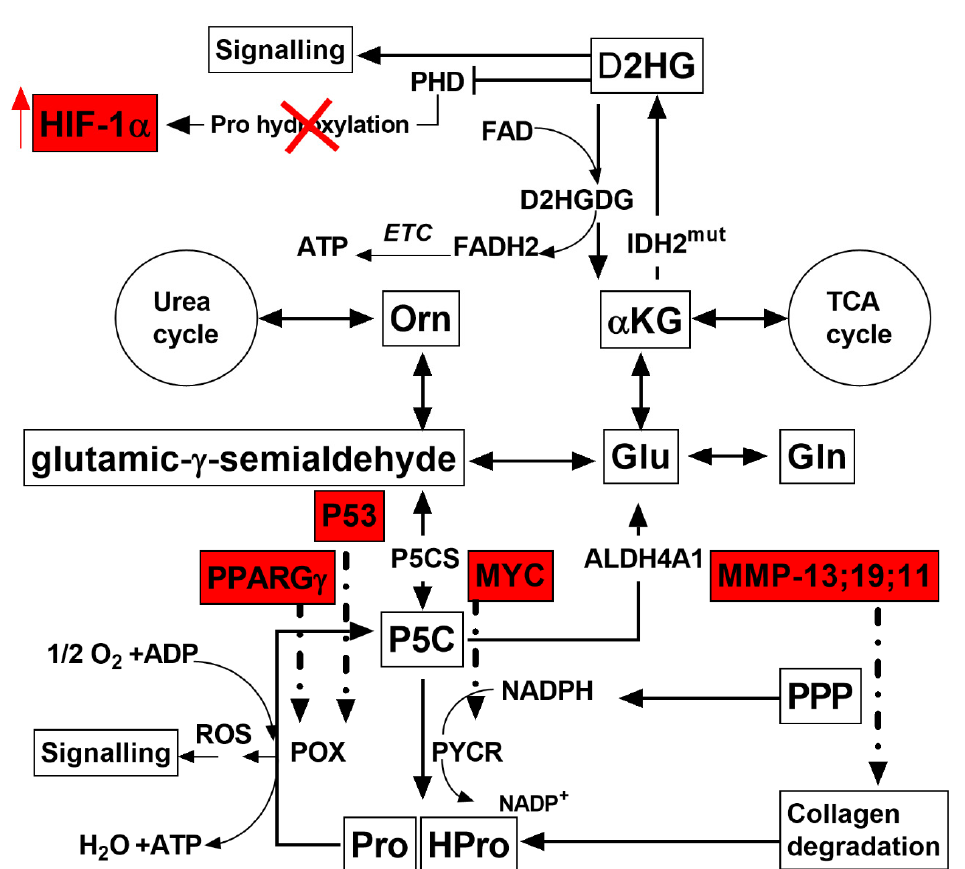
Figure 4. Primary scheme of redox shuttling of Pro/HPro and D2DGDH in the Spalax cells. Red-colored abbreviations and lines represent significantly upregulated mRNAs in the liver tissues of Spalax cells compared to the rat cells. IDH2 mut , mutant IDH is known to facilitate 2HG production; nonetheless, the Spalax gene (NCBI Reference Sequence XP_008844432.1) does not harbor these mutations/substitutions.